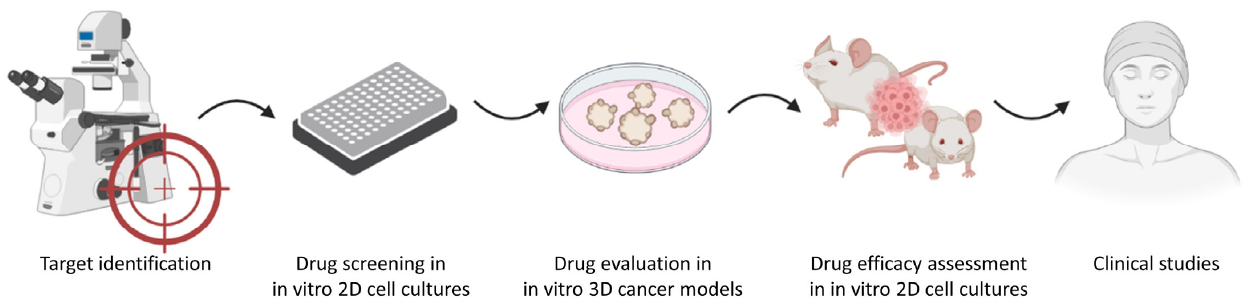
Figure 5. Overview of a possible drug development pipeline that includes the drug e ffi cacy evalua- tion in 3D in vitro cancer models before in vivo testing in animal